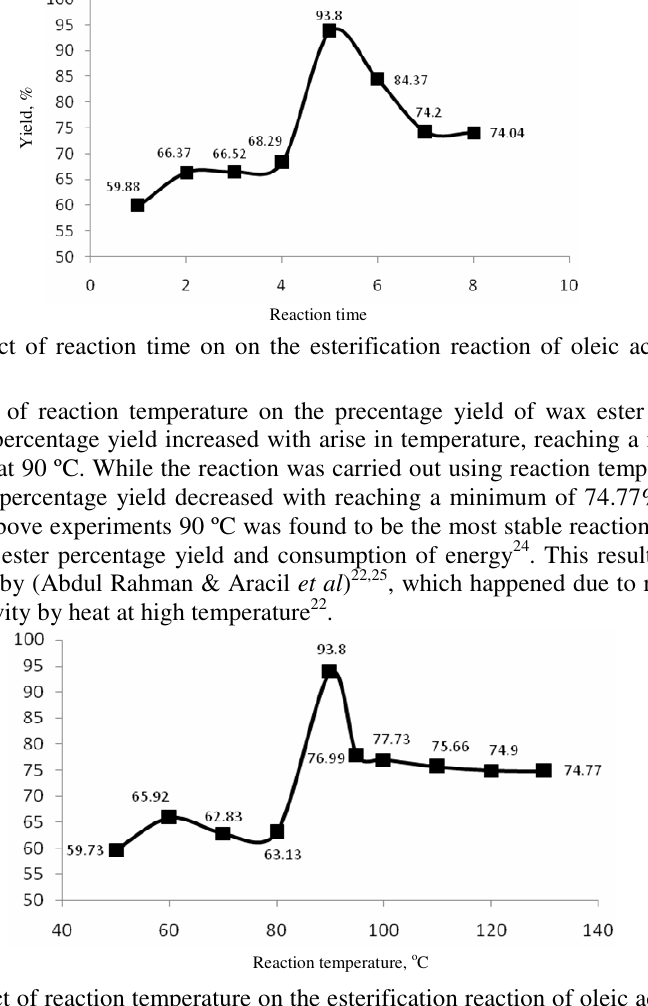
Figure 5. Effect of reaction temperature on the esterification reaction of oleic acid and oleyl